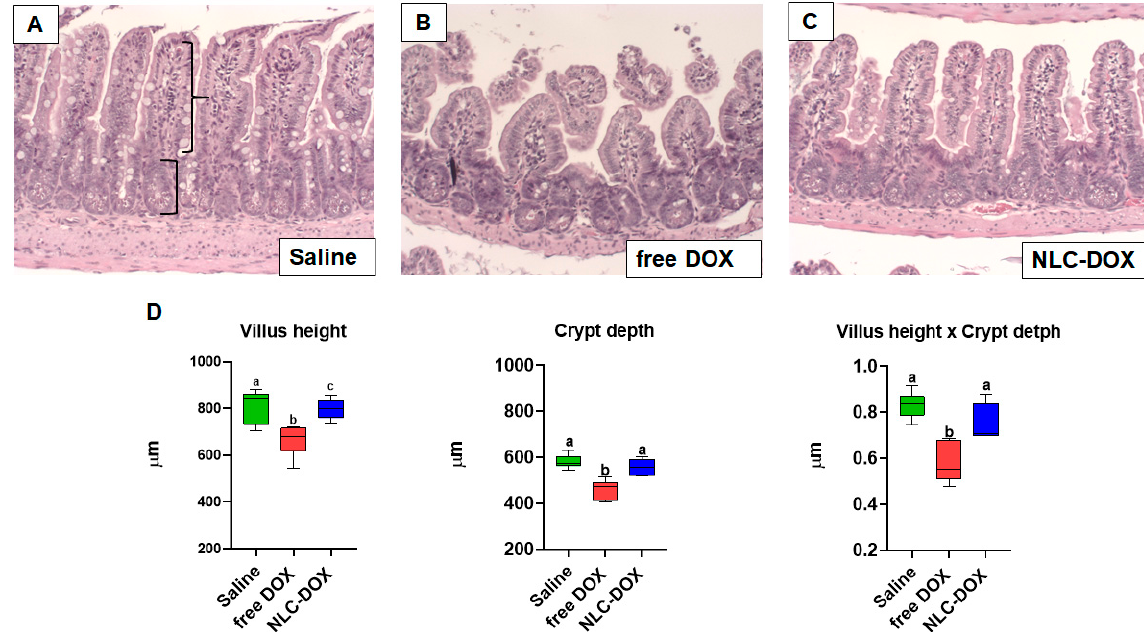
Figure 5. NLC-DOX prevented DOX-induced mucositis-associated intestinal morphological alterations. ( A – C ). Representative histological slides of ileum of Saline, free DOX and NLC-DOX treated animals (20 × magnification). ( D ) Histomorphological analysis of jejune and ileum was used to quantify the height of the villus (represented by curly bracket), depth of the crypts (represented by square bracket). Statistical analysis was performed by using the ANOVA test, followed by the Tukey test. Different letters represent p < 0.05. N = 10 animals per group. Data are a pool from 2 experiments performed. Abbreviations: DOX, doxorubicin; NLC, nanostructured lipid carrier.